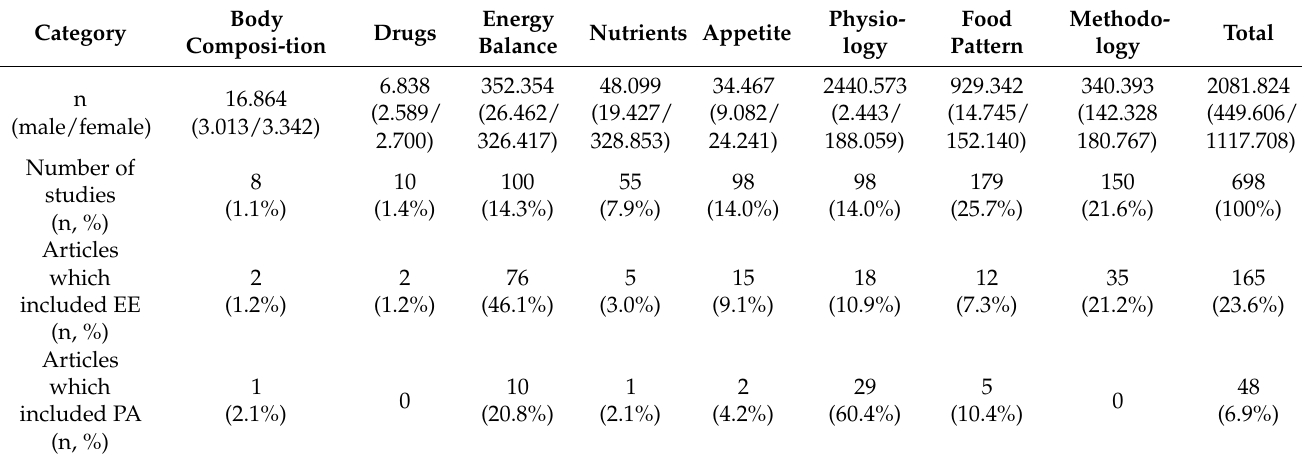
Table 1. Descriptive characteristics by categories.